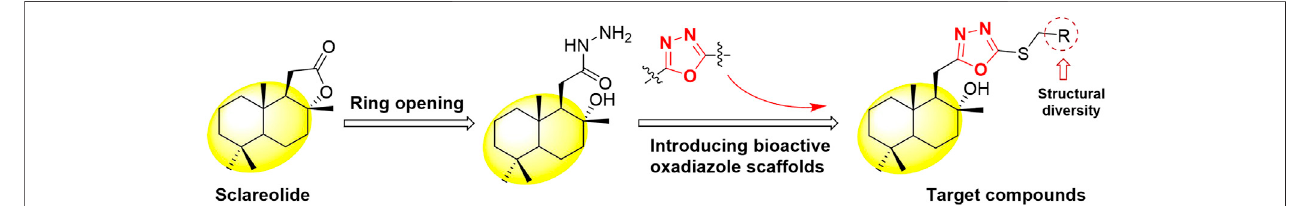
FIGURE 1 | Design strategy of the target